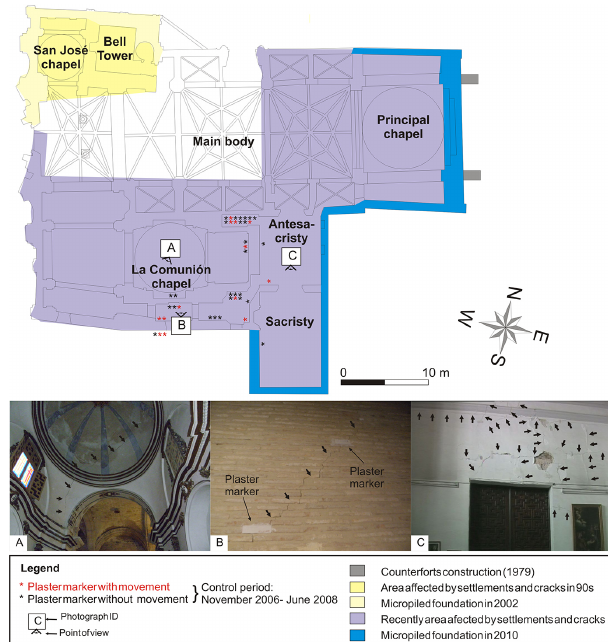
Figure 10. Location of the structural damage and restoration and reinforcement actions performed on the Santas Justa and Rufina Church (modified from Tomás et al.,